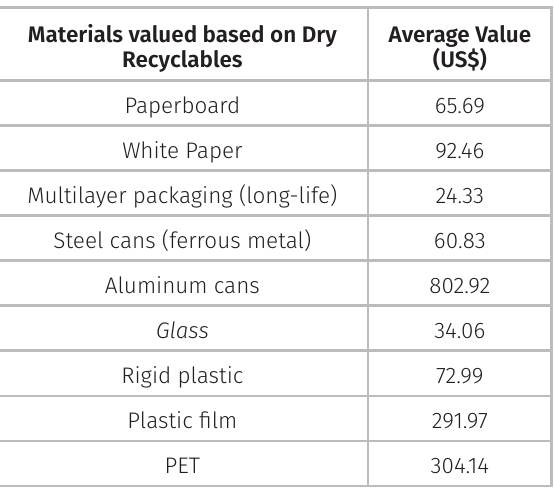
Table II. Values of clean material, prices per metric